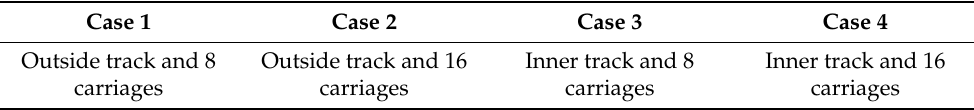
Table 2. Four cases of train load for data classification.